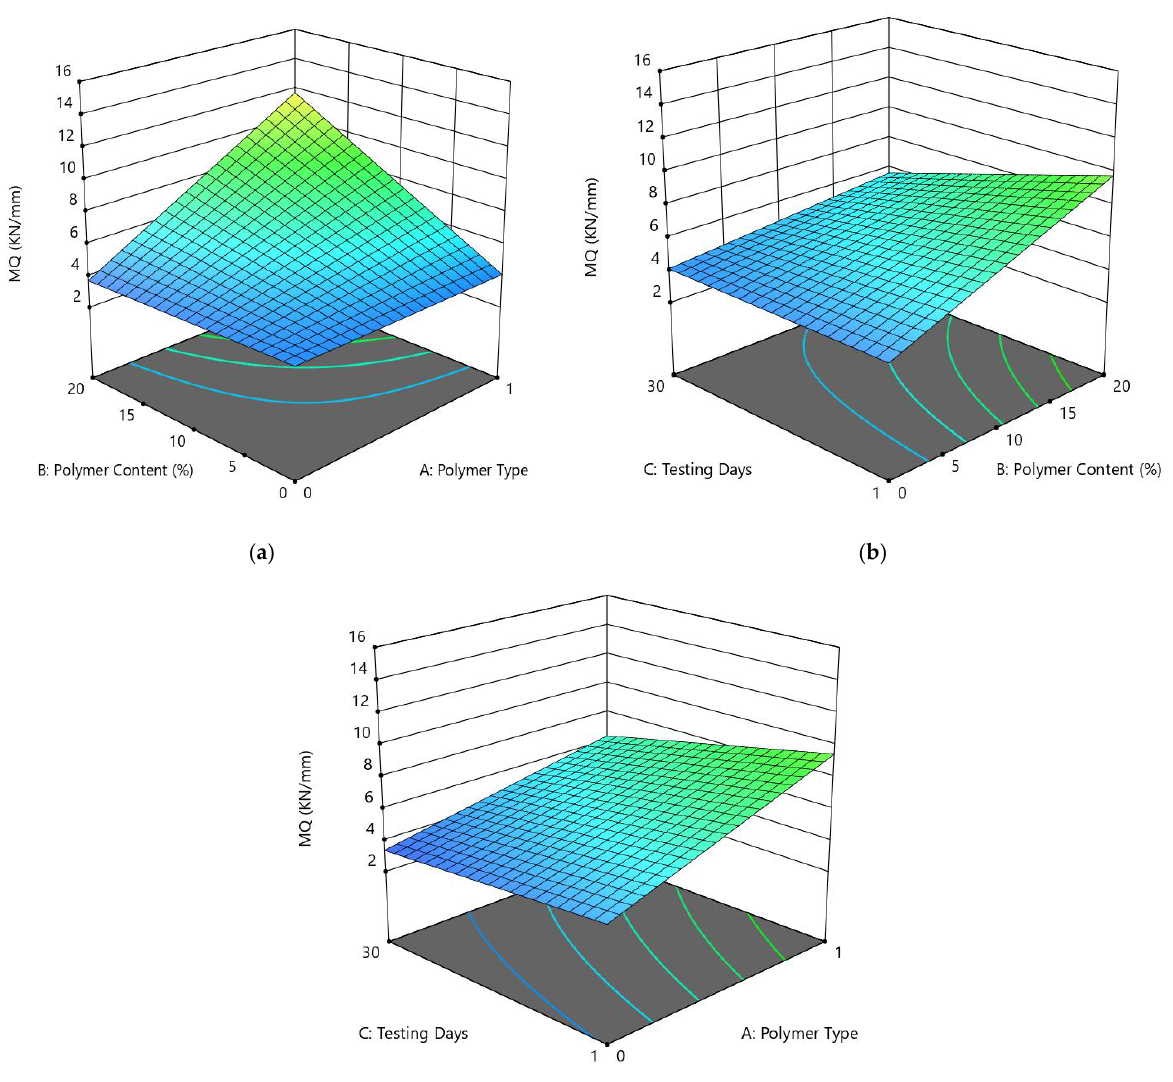
Figure 15. 3D-Response surface plots for the MQ (kN/mm) and three factors ( a ) AB, ( b ) AC, ( c ) BC.